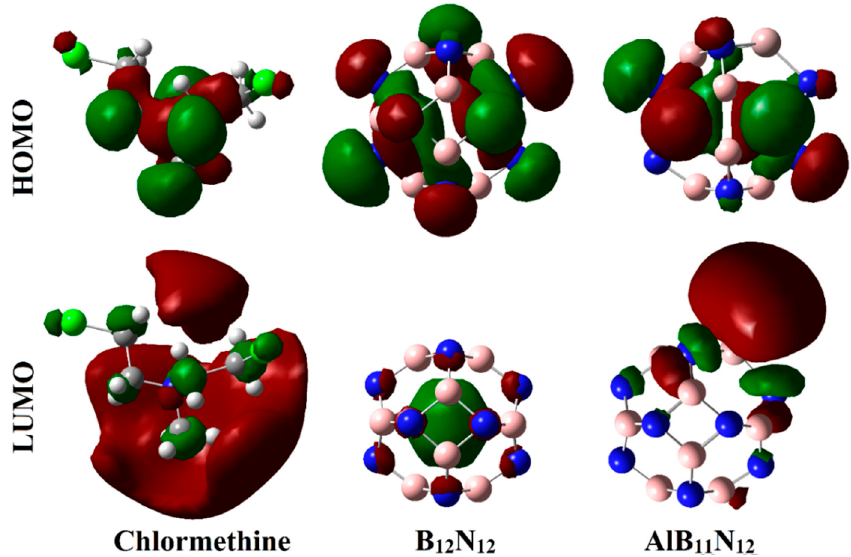
Figure 6. Diagrams of HOMO and LUMO distributions of CM, B 12 N 12 , and AlB 11 N 12 systems. Table 3 . The highest occupied molecular orbital ( E HOMO ), Fermi level ( E FL ), and the lowest unoccu- pied molecular orbital ( E LUMO ), as well as the energy gap ( E gap ) of optimized CM, B 12 N 12 , and AlB 11 N 12 before and after adsorption process. All values are given in eV.